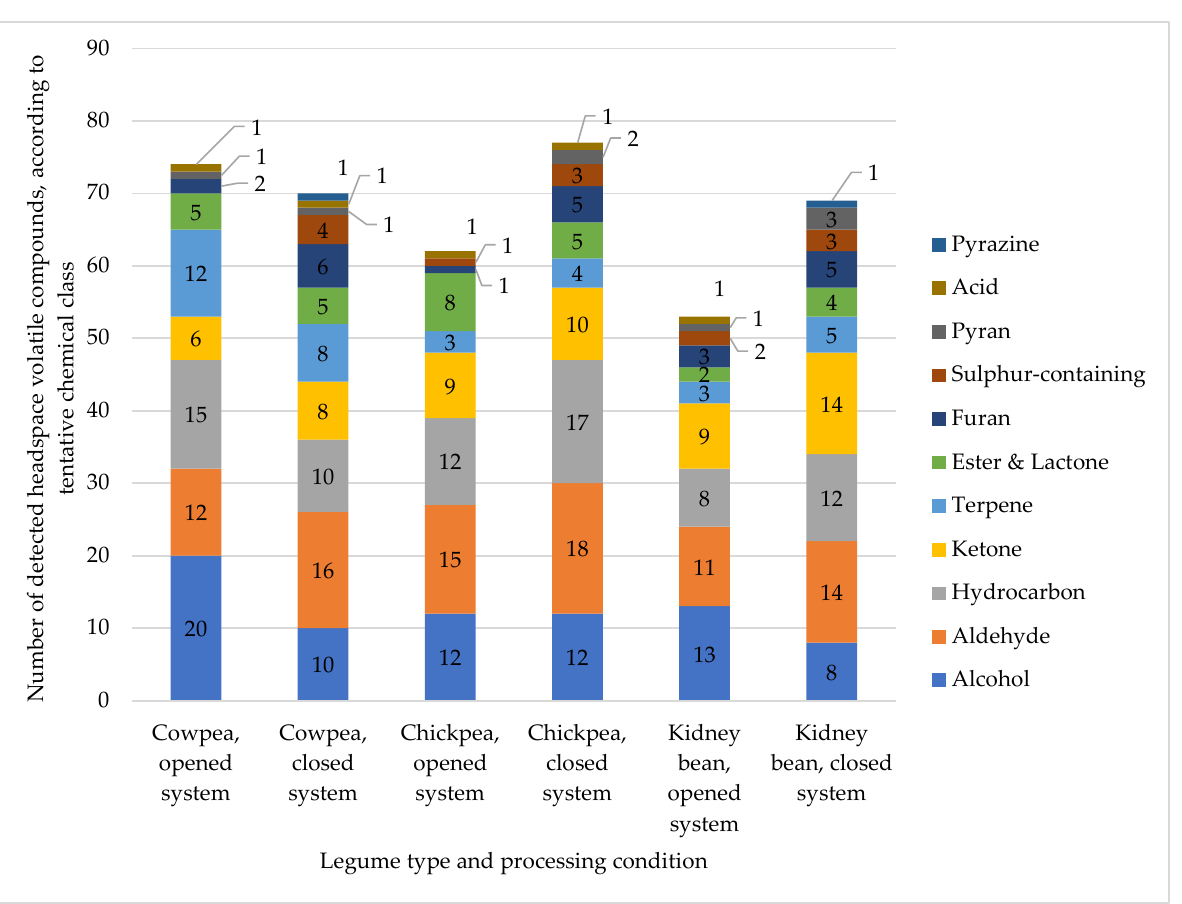
Figure 1. Comparison of number of detected headspace volatile compounds between the opened and closed system of processing, with tentative chemical classes